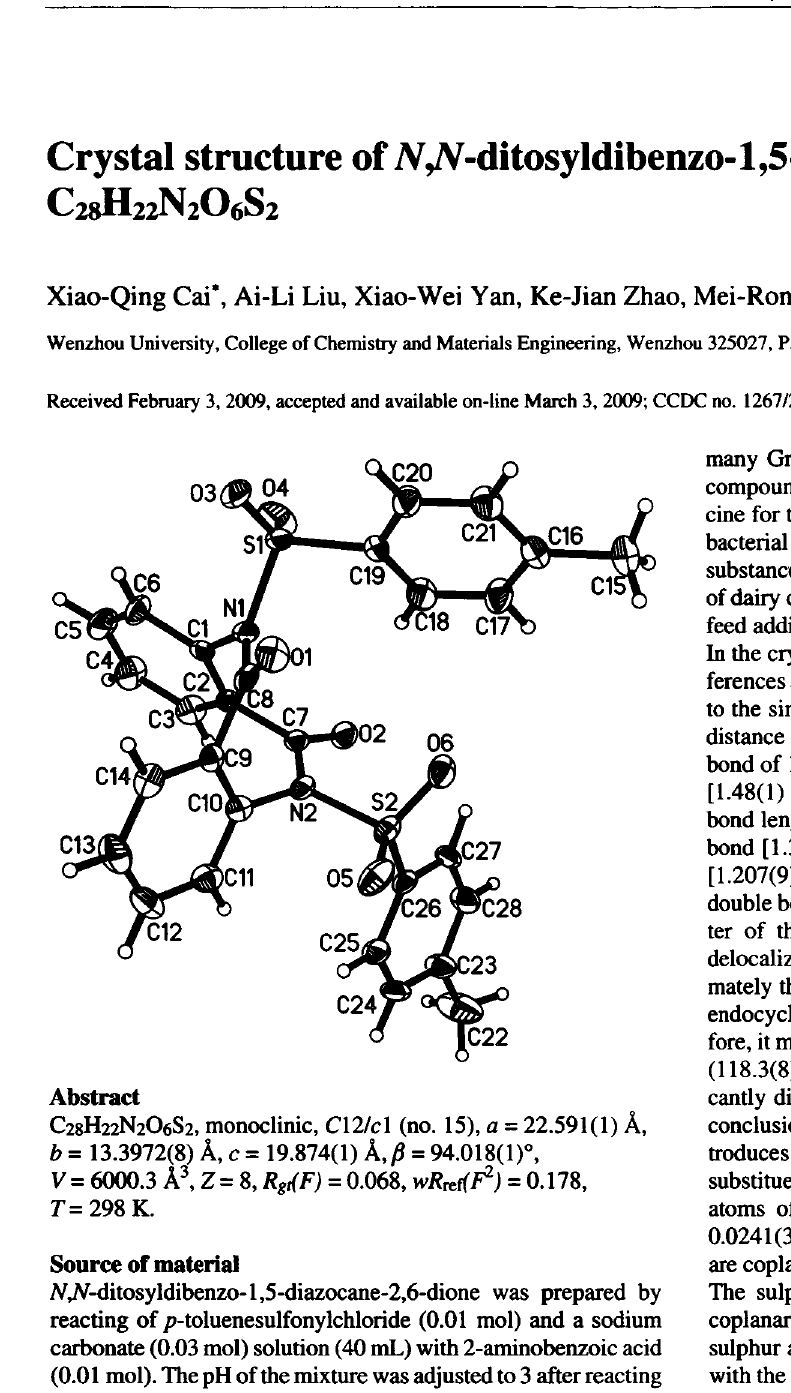
Table 1. Data collection and